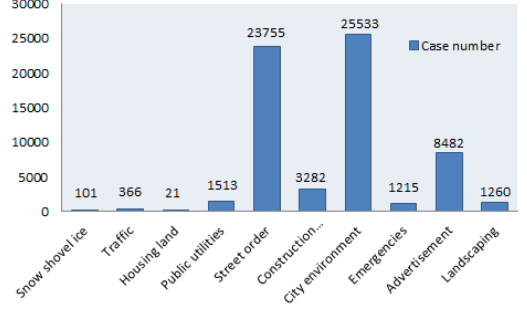
Figure2. Data statistical histogram